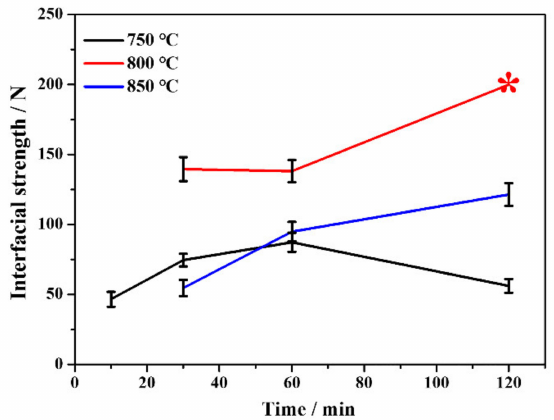
Figure 3. Variation of interfacial strength of Ta coatings with alloying temperatures and time. The asterisk represents the estimated